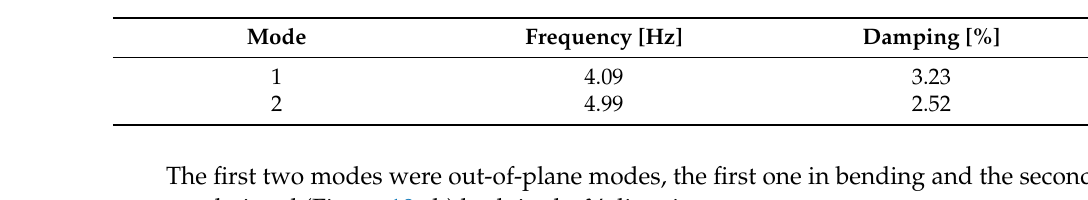
Figure 9. ( a ) Set up no. 1; ( b ) Set up no. 2; ( c ) Singular value decomposition of the acquired data. The obtained measured data for the first two modes is given in Table 1. Table 1. Identifies measured dynamic properties.